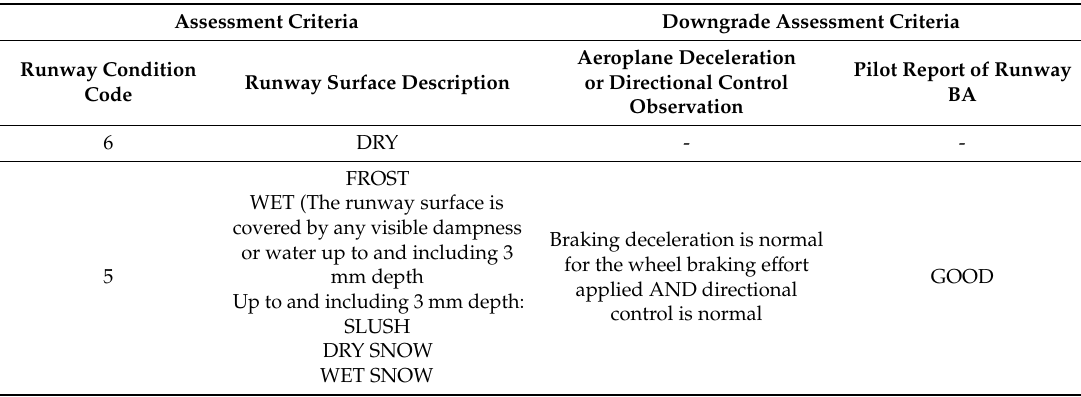
Table A1. Runway Condition Assessment Matrix (RCAM)